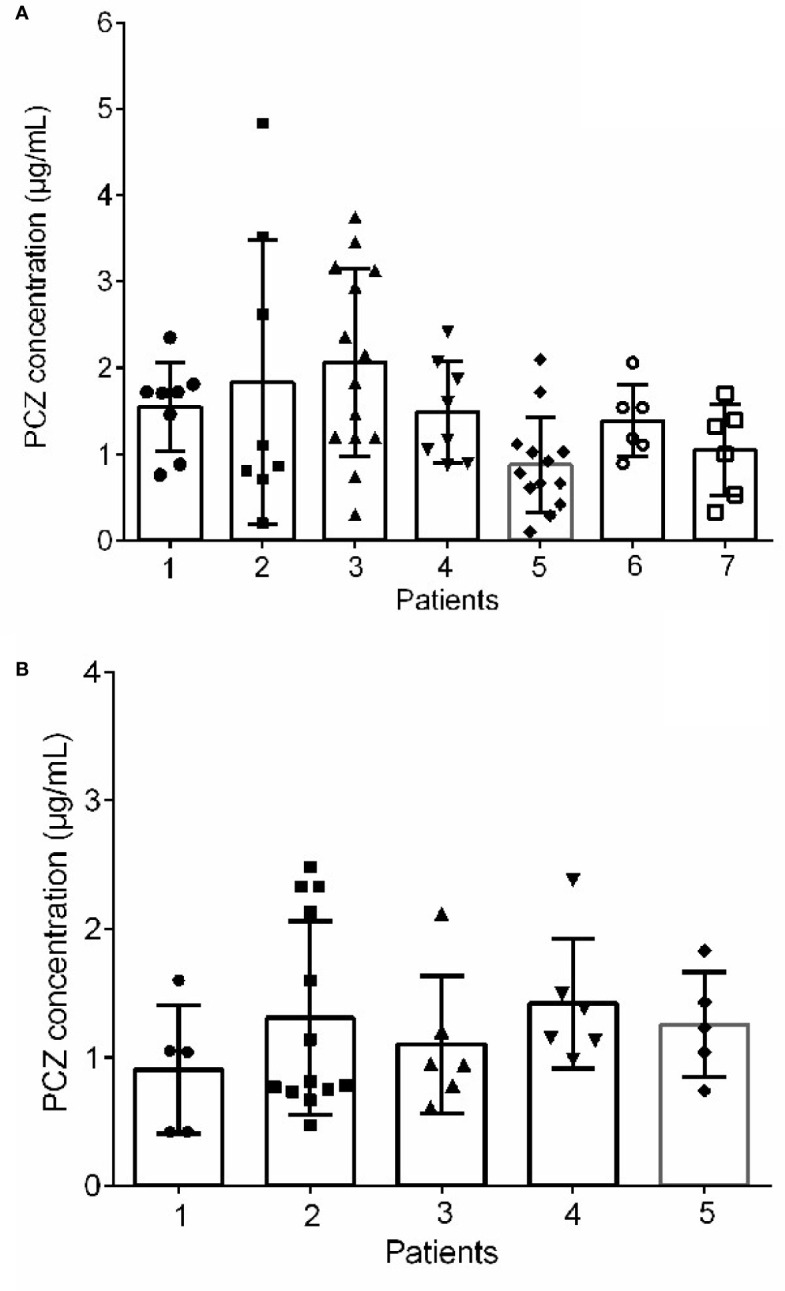
Intra‐and inter-patient variability for patients received 800 mg/day of PCZ suspension in prophylaxis (A) and treatment (B) groups. The graphs show mean values and SD values.